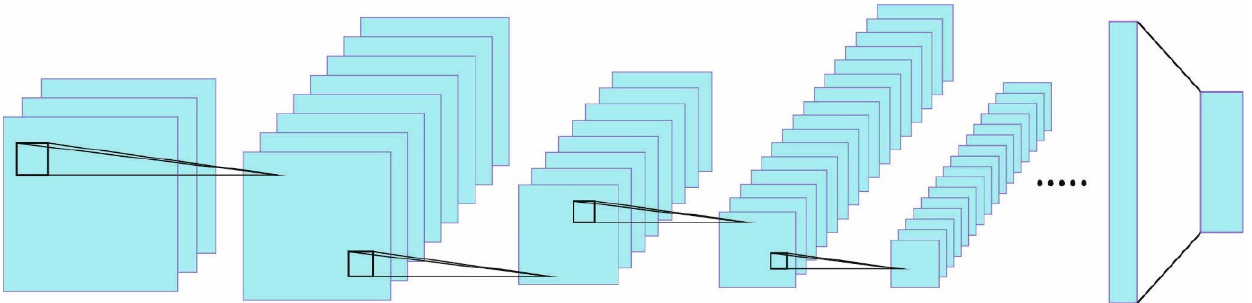
Figure 1. Overall process of PODCNN-LWID approach.